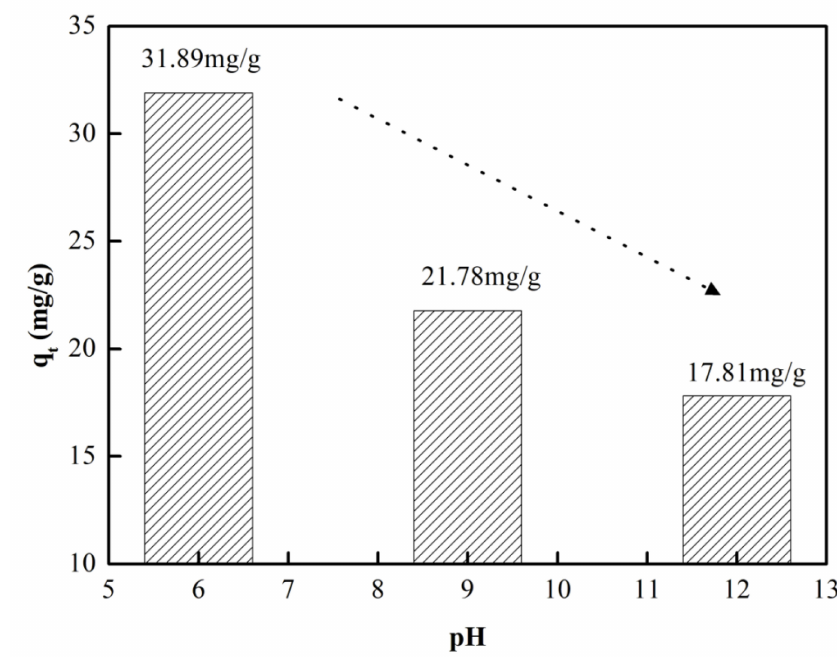
Figure 7. Adsorption capacities of CFBs for CTC at different pH